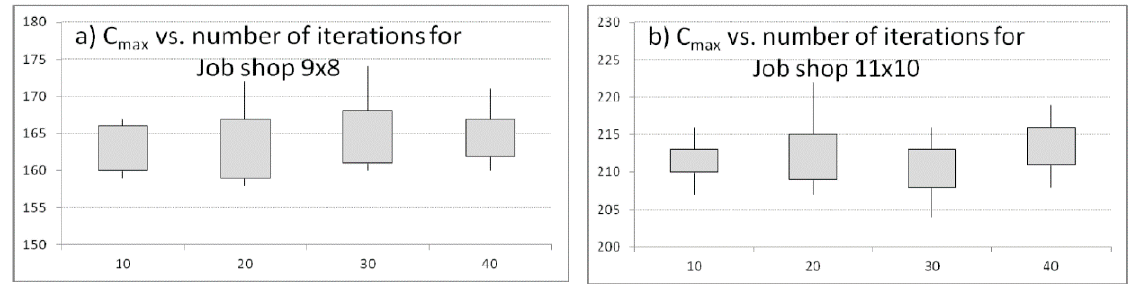
Figure 3. The C max of the basic schedules achieved by the ACO for different iteration numbers.